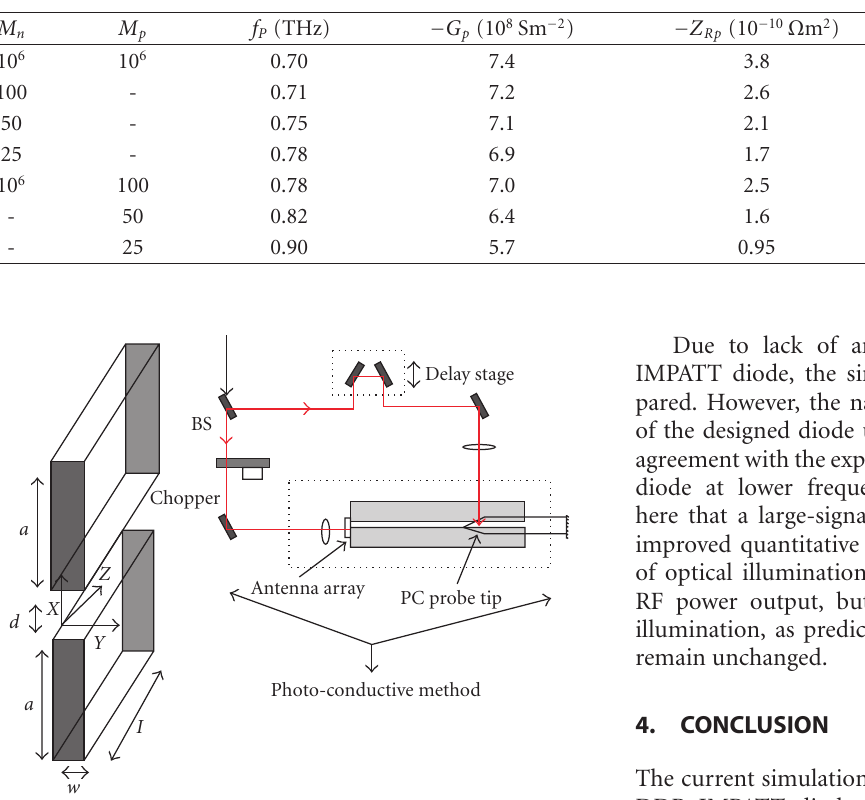
Table 4: Variation of small-signal properties of 4H-SiC DDR IMPATT under optical-illumination.